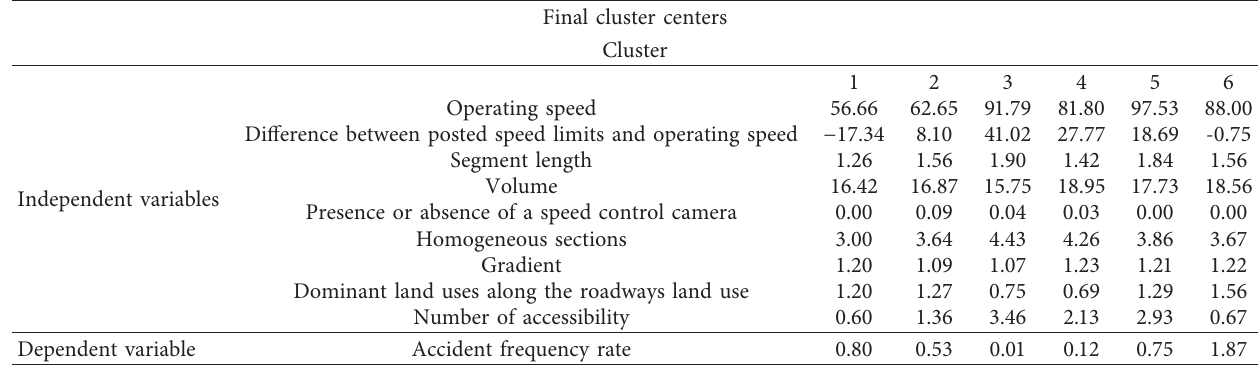
Table 3: Final cluster centers for independent and dependent variables in this study.